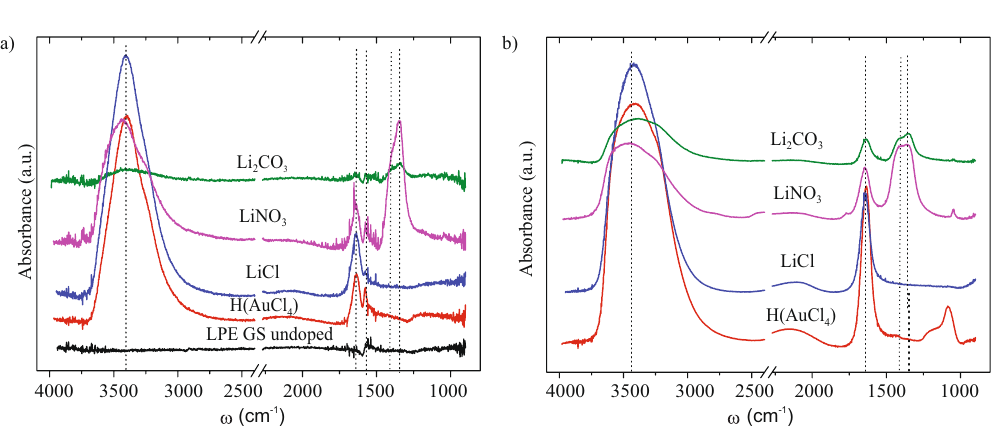
Figure 3. ( a ) Raman spectra of the undoped LPE GS film and films doped with Li and Au salts, ( b ) FWHM of the four basic Raman peaks ( c )The intensity ratio of D to G peak for different doping metal salts, I(D)/I(G), ( d ) The intensity ratio of D to D’ peak, I(D)/I(D’), for different doping metal salts. We refer to peak intensity as the height of the peaks as proposed by Eckmann et al . 32 .